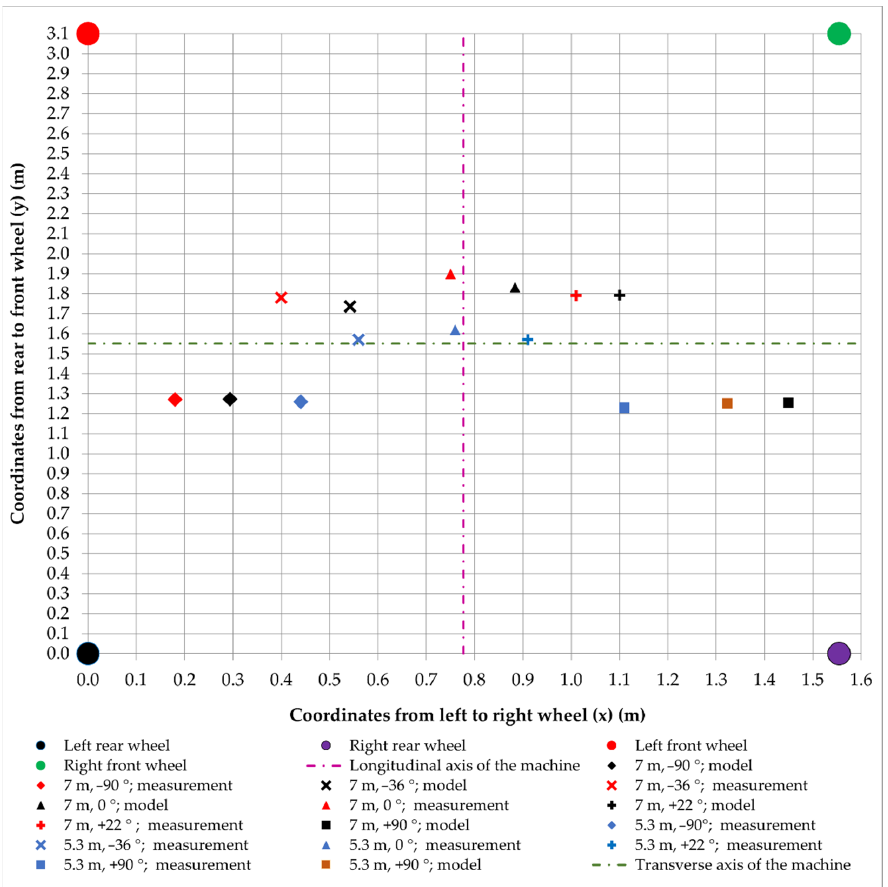
Figure 8. Center of gravity—Position 4.